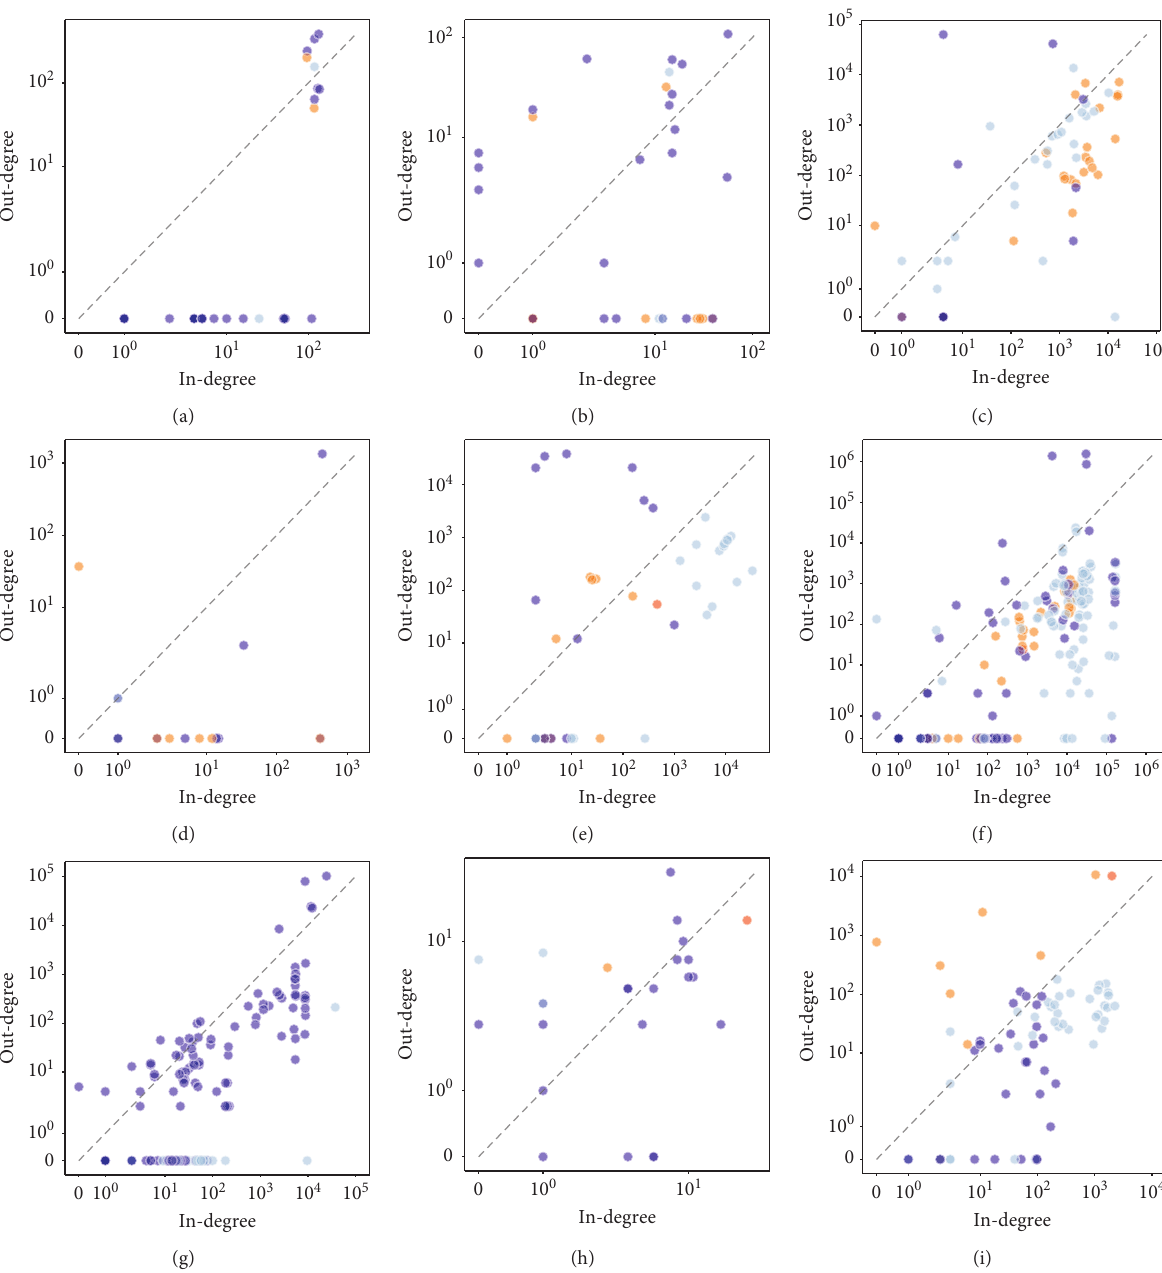
Figure 4: In-degree vs out-degree scatter plots of functional communication networks from select enterprises. Dots are user colored by their role (red is for an executive, dark blue is for a manager, orange is for a supervisor, and light blue is for an operator). Dots above the diagonal are users that assign more work orders than they receive. Dots below the diagonal are users that receive more work orders than they assign. Dots near the diagonal are users that assign approximately as many work orders as they